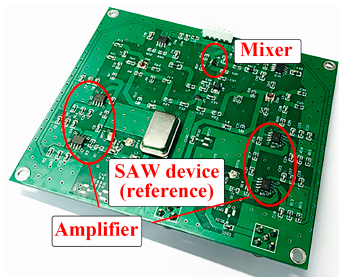
Figure 14. Photograph of a fabricated dual-port SAW oscillator.